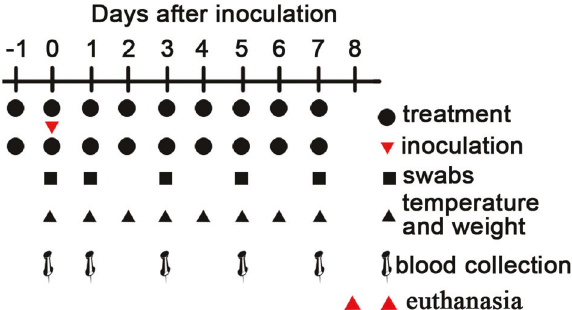
Fig. 4 Schedule of nel fi navir treatment and SARS-CoV-2 infection in rhesus macaques. To evaluate the prophylactic ef fi cacy of nel fi navir treatment in the SARS-CoV-2 infection model in rhesus macaques, one group of three rhesus macaques was administered 200 mg/kg nel fi navir three times by nasogastric administration before SARS- CoV-2 (strain 20SF107) inoculation (black circles). One group of three control animals was administered 5 mL/kg vehicle solution (0.5% CMC-Na) by nasogastric administration. Treatment was continued twice daily until 7 dpi, then all animals were euthanized on 8dpi. At 0, 1, 3, 5, and 7 dpi, nasal, throat, and rectal swabs were collected. Temperature and weight changes were monitored at 0, 1, 2, 3, 4, 5, 6, and 7 dpi. Blood samples were taken at 0, 1, 3, 5, and 7